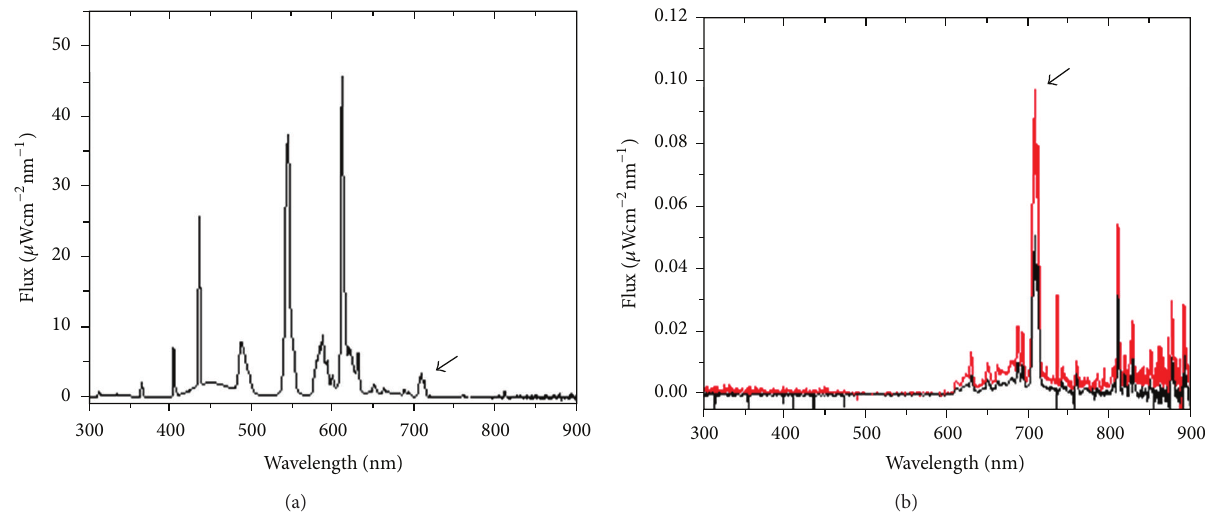
Figure 2: Analysis of the fluorescent light spectrum penetrating into the substantia nigra . (a) Spectrum of the fluorescent tube registered by the microoptic fibre directly facing the lamp. (b) Representative light spectrum measured by the optical probe inside the rat brain. The black line and the red line refer to readings taken with covered and uncovered eyes, respectively. The arrows indicate the peaks at ∼ 710